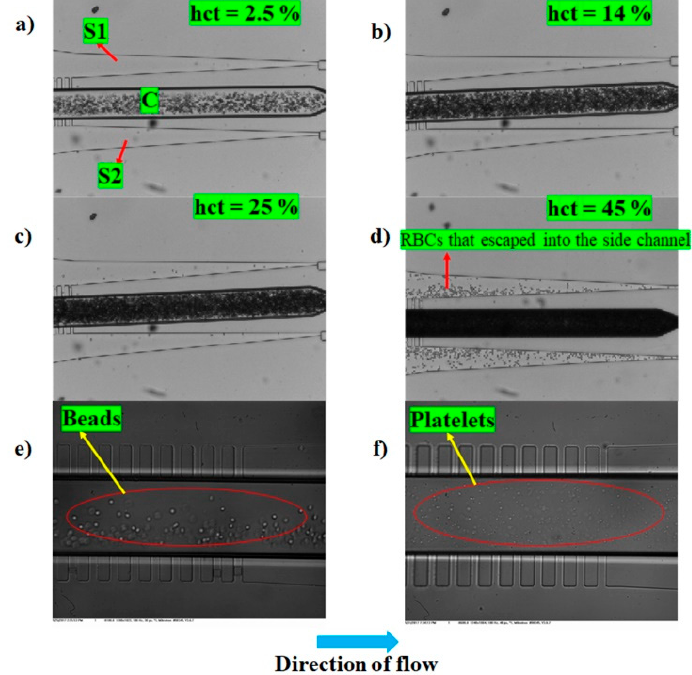
Figure 9. Experimental images illustrating the functioning of the proposed device for various particle concentrations and sizes. ( a )–( d ) represent the experimental images depicting the concentration of RBCs in central channel C and those that escaped into the side channels S1 and S2 for different values of hematocrit. ( a ) 2.5% hematocrit, ( b ) 14% hematocrit, ( c ) 25% hematocrit, and ( d ) 45% hematocrit. ( e ) and ( f ) represent the experimental images depicting the localization of particles (5 μ m beads and platelets) to the central region C alone. The SCRR of the devices used in ( a )–( d ) is 100 and in ( e ),( f ) is 50.